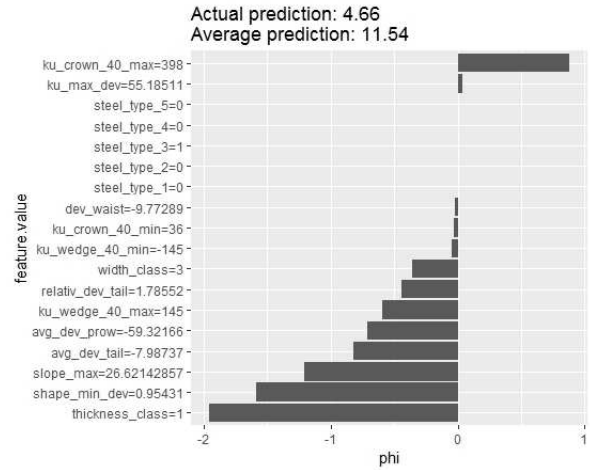
Figure 11: SHAP values for a good product with a prediction of 4.66, while the average prediction is 11.54 inside the group of